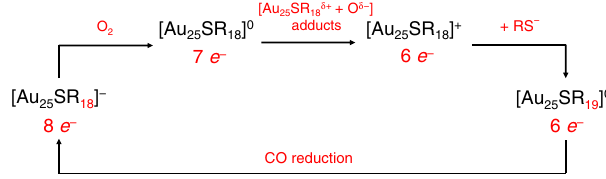
Fig. 1 Schematic illustration of reaction process. Schematic illustration of the addition/elimination reaction cycle between [Au 25 SR 18 ] − and [Au 25 SR 19 ] 0